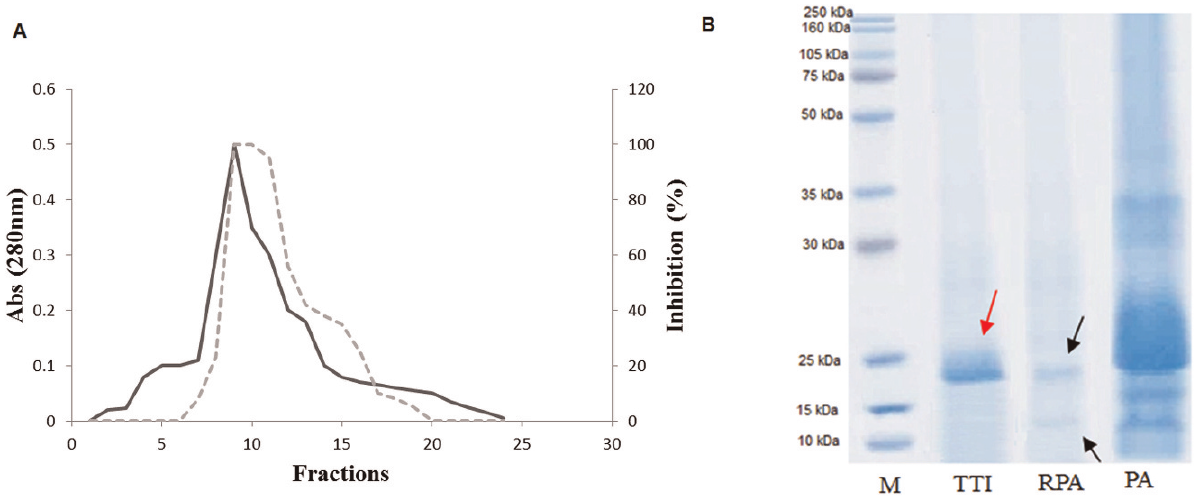
Figure 1 - Trypsin-Sepharose 4B affinity chromatography of the tamarind seed trypsin inhibitor (TTI). A) Elution profile of the retained acetone-precipitated fraction (RPA). Adsorbed proteins were monitored at 280 nm (-). The inhibitory activity on trypsin (---) was assayed using 100 m L of TTI. B) Denaturing electrophoresis on a 12% polyacrylamide gel after staining with Coomassie Brilliant Blue R- 250. M, Molecular mass markers; PA, precipitated with acetone; RPA, fraction obtained after precipitation with acetone isolated by Trypsin-Sepharose affinity chromatography and TTI, tamarind trypsin inhibitor, isolated by Trypsin-Sepharose affinity chromatography and subjected to dialysis. The arrows indicate 14 kDa for RPA and 20 kDa for